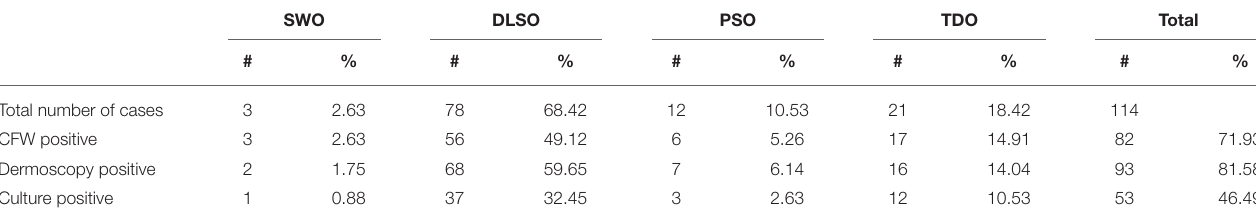
TABLE 1 | Clinical staging of 114 patients and positivity rate of the three tests. SWO DLSO